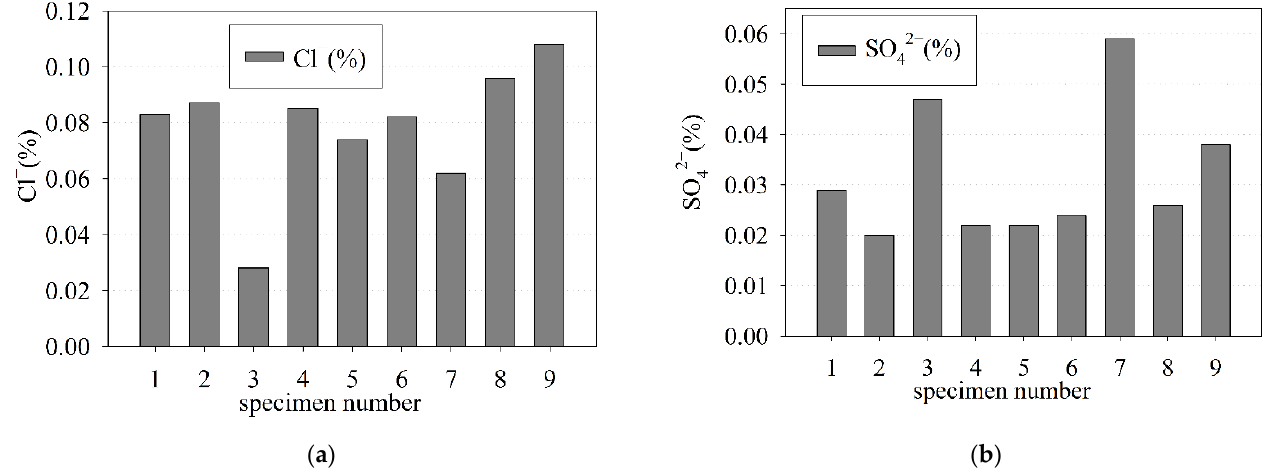
Figure 11. Content as the dry weight percentage of water-soluble ( a ) chloride ions (Cl − ); ( b ) sulfate ions (SO 42 − ).